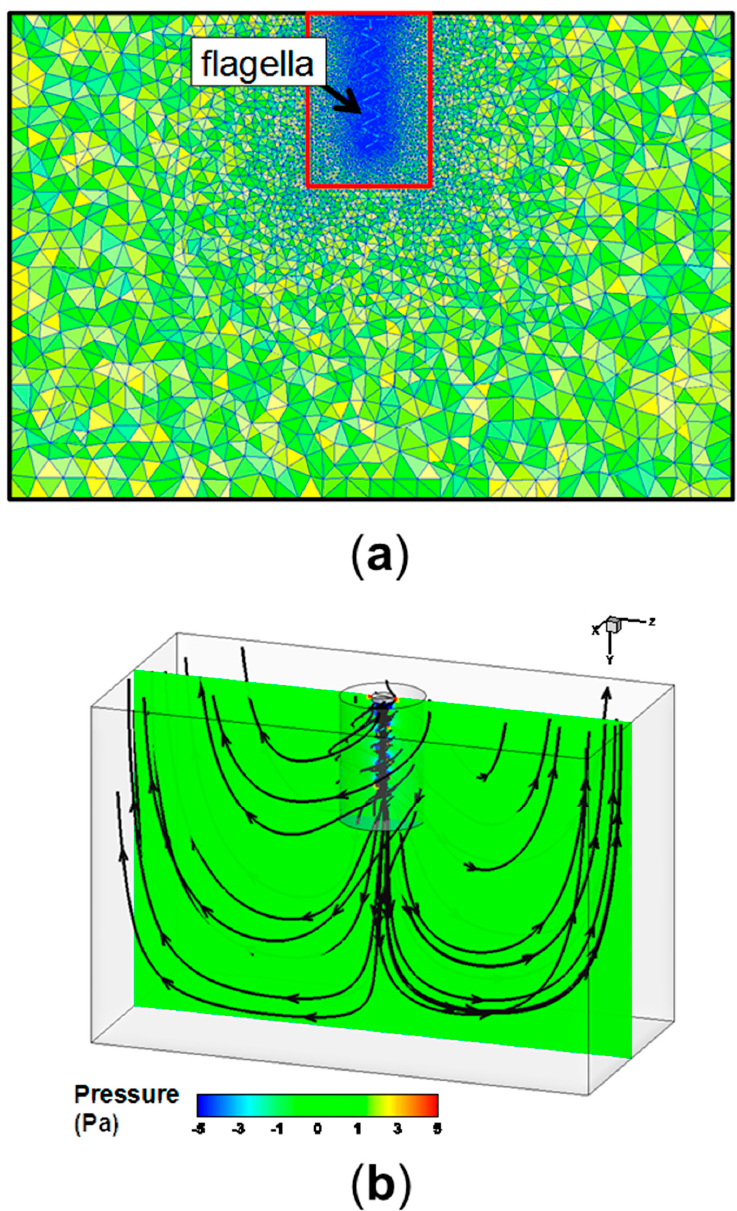
Figure A1. Computational domain for the CFD simulations of the flagella propulsion ( a ) comprised of inner rotating reference frame (red rectangle) and the stationary frame (black rectangle). Helical flow structures around the counter-rotating flagella mapped on the uniform pressure field plotted at the center plane of the flagella ( b ).